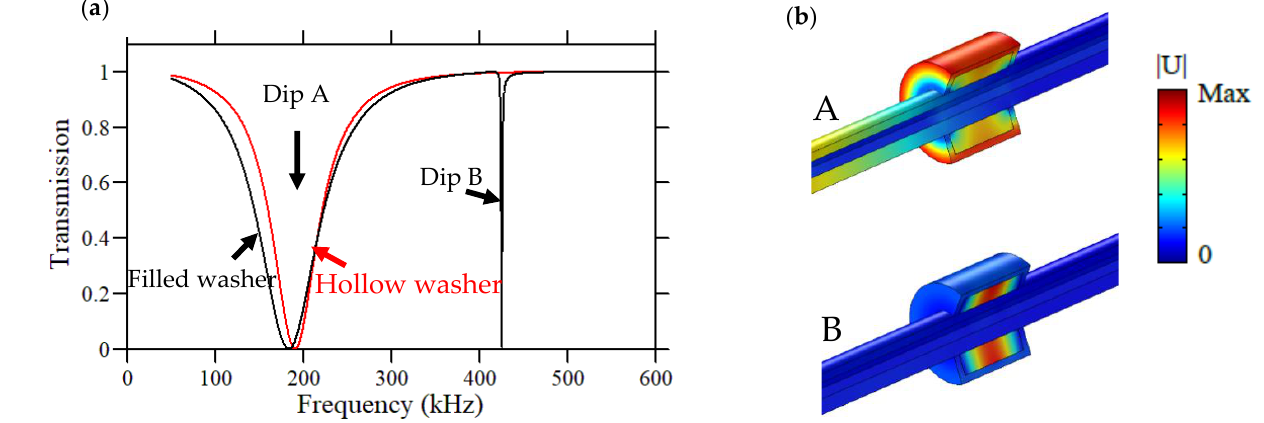
Figure 2. ( a ) Transmission curves of the acoustic liquid sensor when the washer is filled with water (black curve) and when it is empty (red curve). ( b ) Maps of the displacement fields of dips A and B.